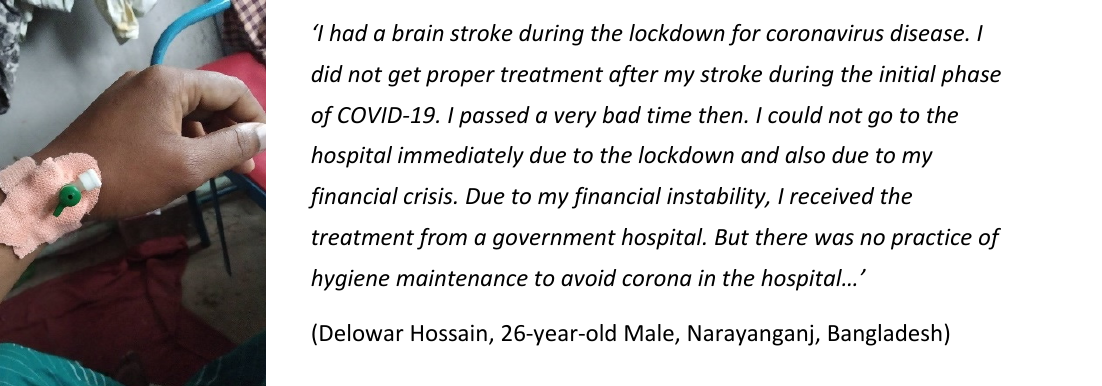
Figure 16. Alt-text: A large crowd of people sitting outdoors for Eid prayers. Figure 17. Alt-text: A woman dressed in a colourful green, white and purple sari standing in front of bushes and tulsi plants.